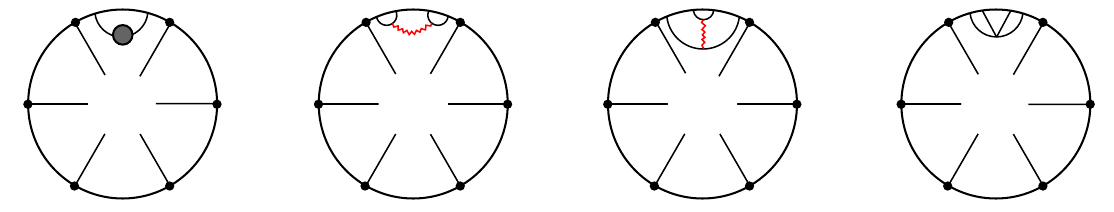
Figure 43 . One-loop corrections to the partially contracted Giant